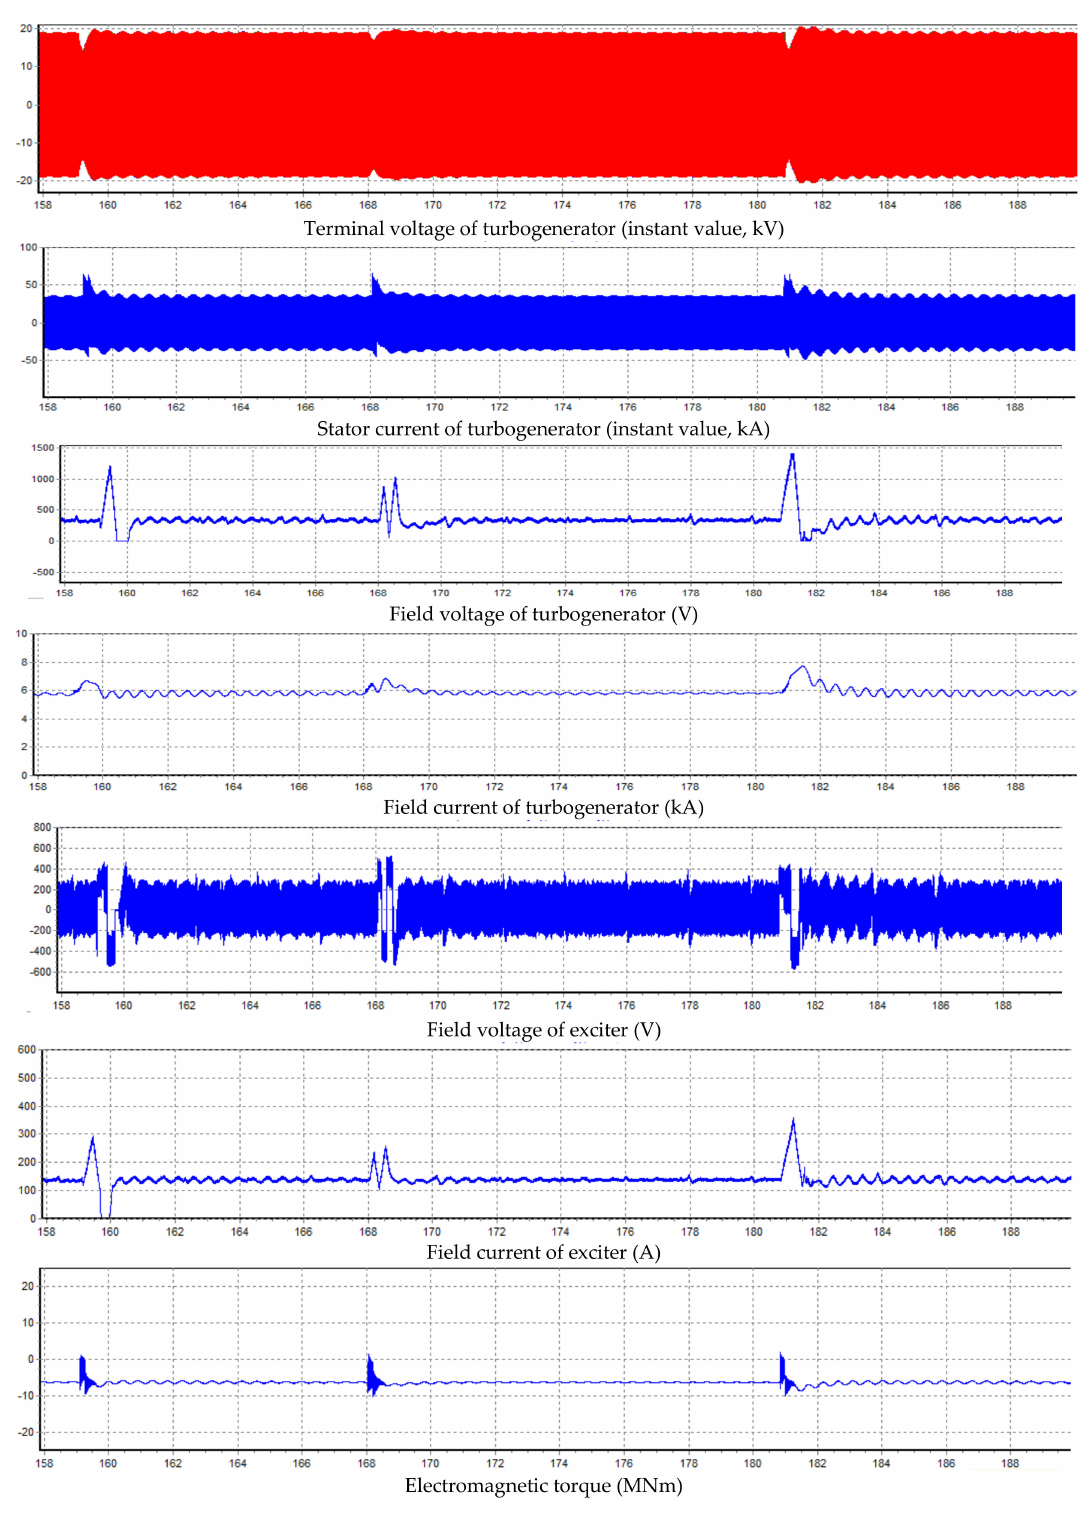
Figure 7. The oscillogram for the mode of the repeated short circuits (one and two-phase) in the power network of the power generation system with a brushless excitation system for the